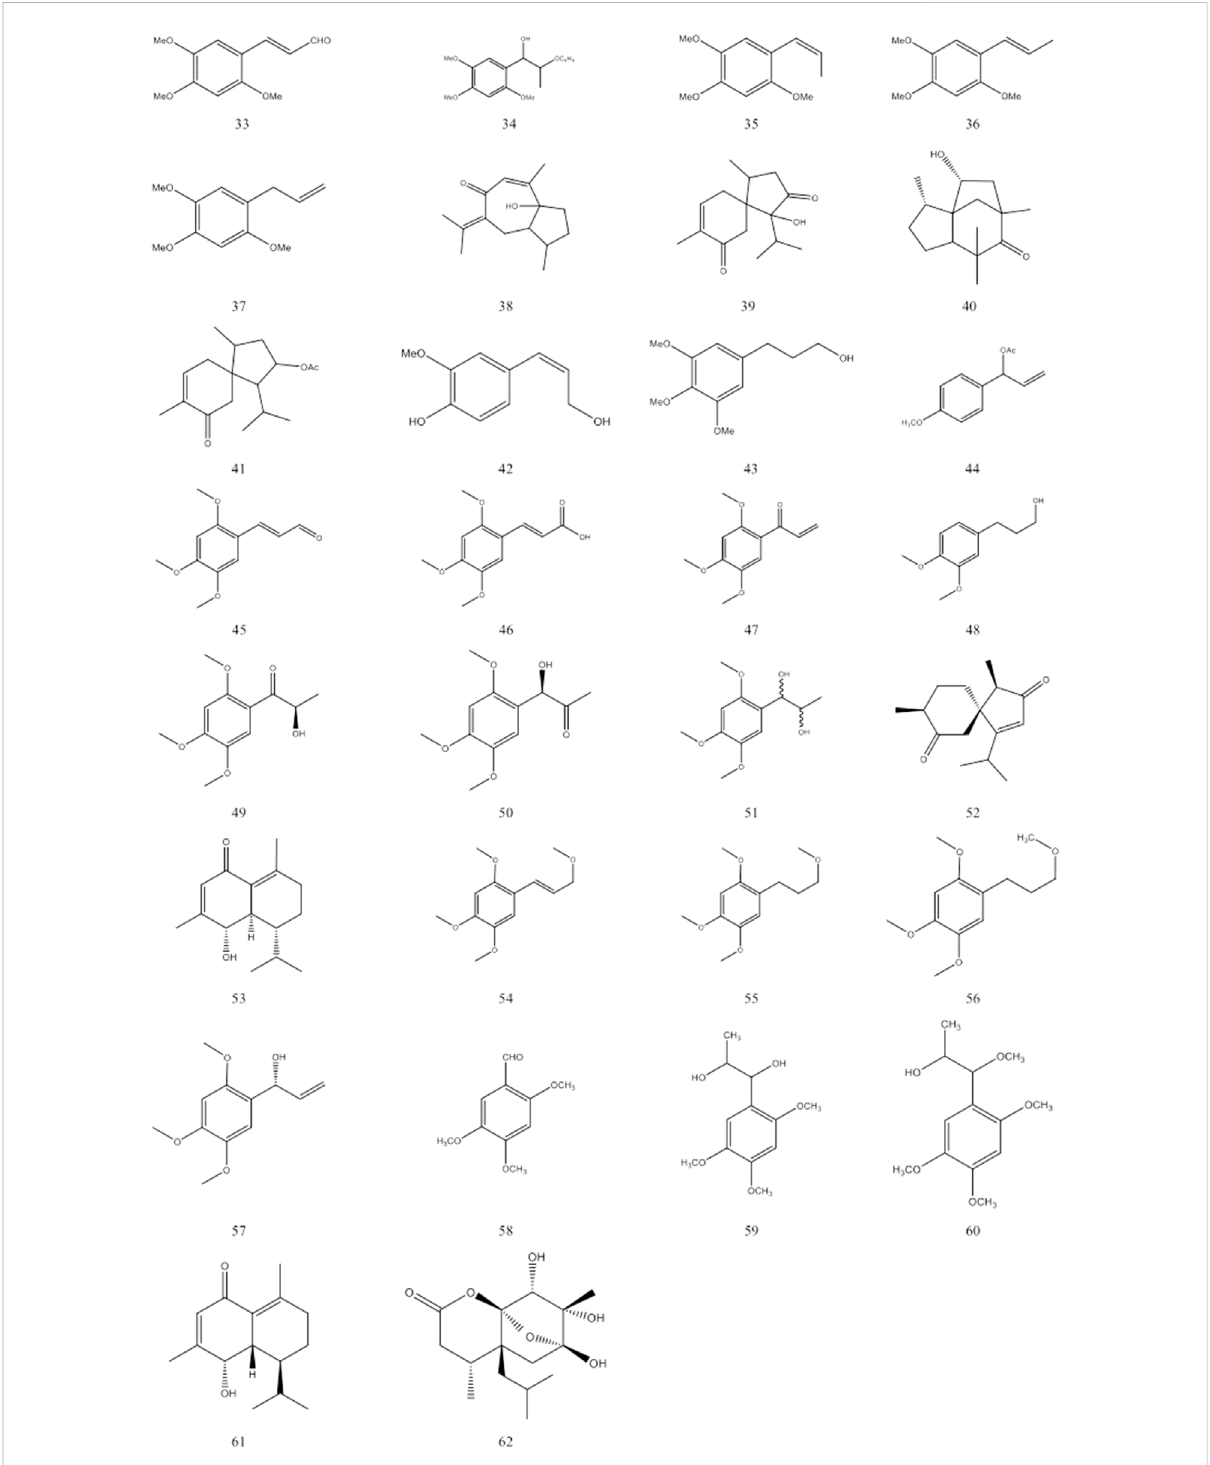
FIGURE 2 The composition of volatile of ATT and their